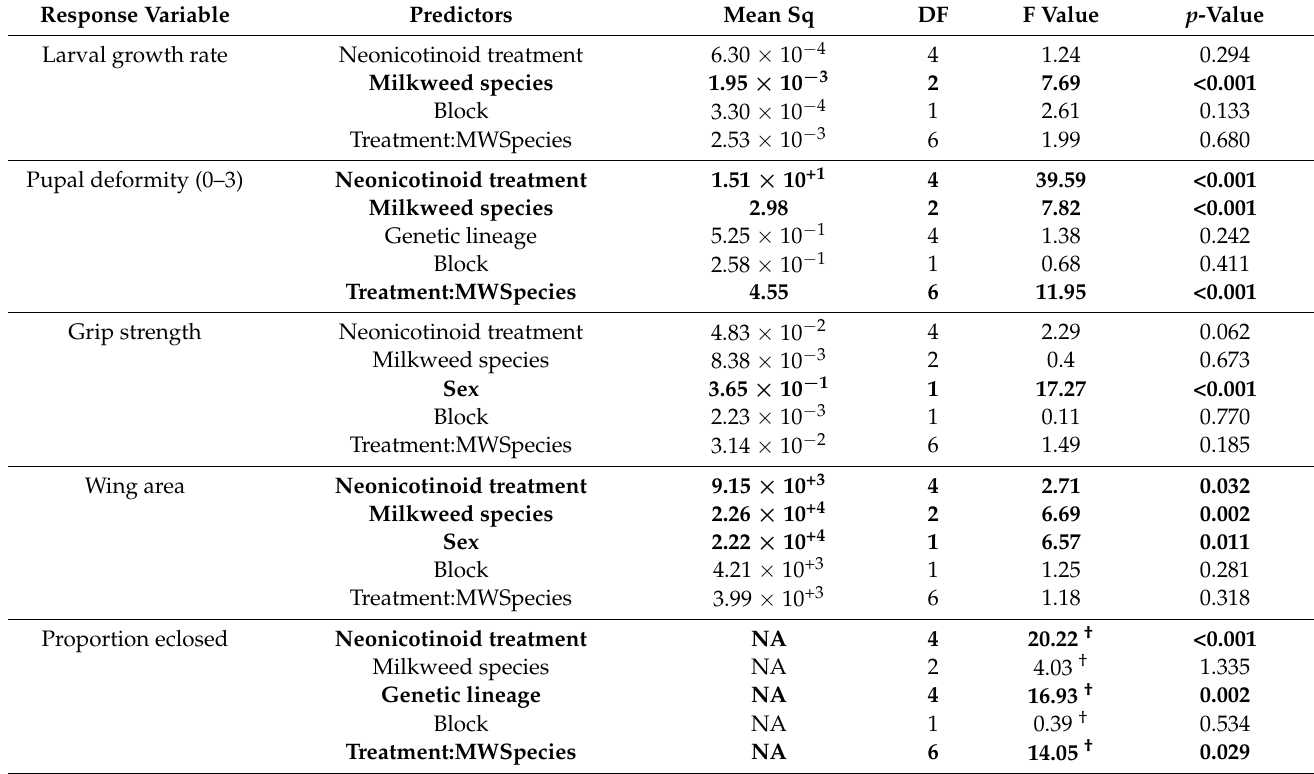
Table 3. Results of general linear models investigating predictors of monarch growth, survival (eclosed), and deformity in Experiment 2, for all 3 milkweed species (swamp, common, and tropical) and 5 insecticide treatments (clothianidin and imidacloprid) (Table S2). Monarch lineage was included as a random effect in all models. Neonicotinoid treatment was included as a fixed factor with 3 levels as described in the Methods section. Survival (eclosed) was treated as a binomial variable (binomial errors, logit link); all other variables were treated as normally distributed. Significant variables appear in bold. † indicates deviance values for variables analyzed using binomial error